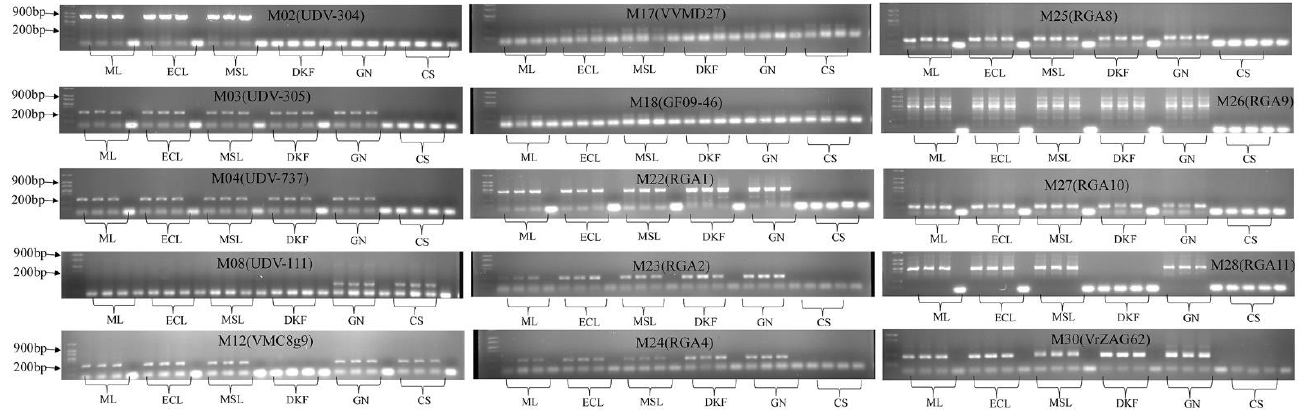
Figure 2. Detection of products from the 15 pairs of disease resistance SSR molecular markers with differences in electrophoresis bands in the six hybrid parents. ML, ECL, MSL, DKF, GN, and CS represent varieties of Meili, Ecolly, Marselan, Dunkelfelder, Garanior, and Cabernet Sauvignon.